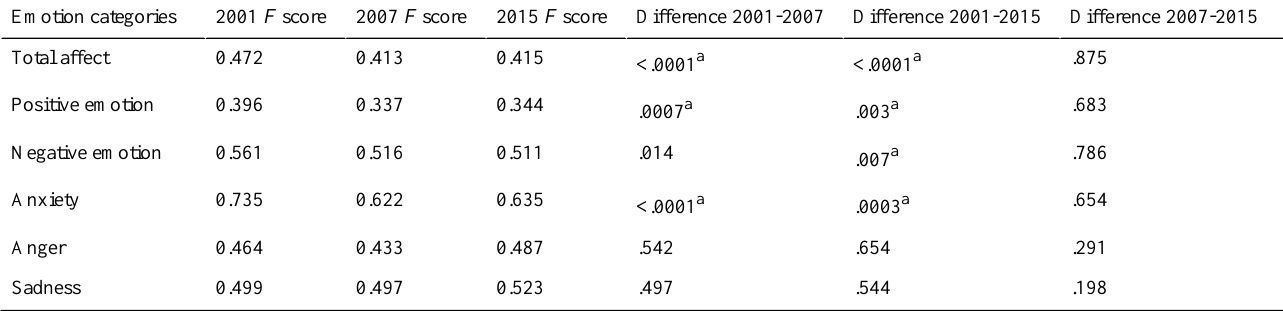
Table 6. Linguistic Inquiry and Word Count 2001, 2007, and 2015 F score